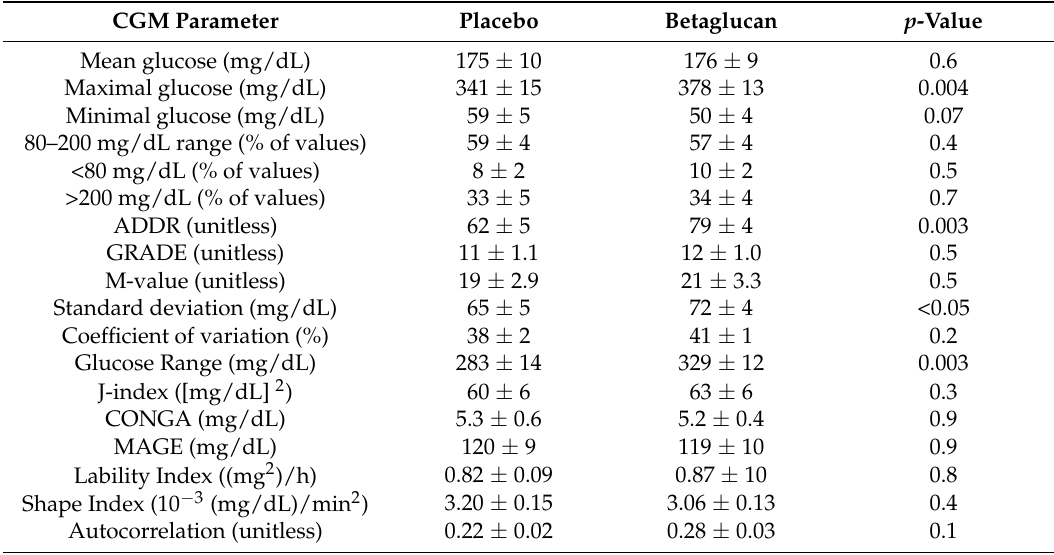
Table 1. Glycaemic control and glucose variability measures during the last 7 days of a two-week period on either placebo or betaglucan tablets three times